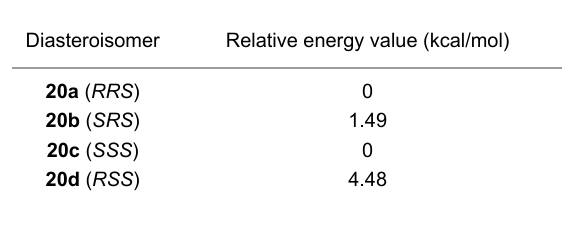
Table 1: Relative energy values (kcal/mol) of the four diastereoisomer 20a–d calculated by the HF/631G*